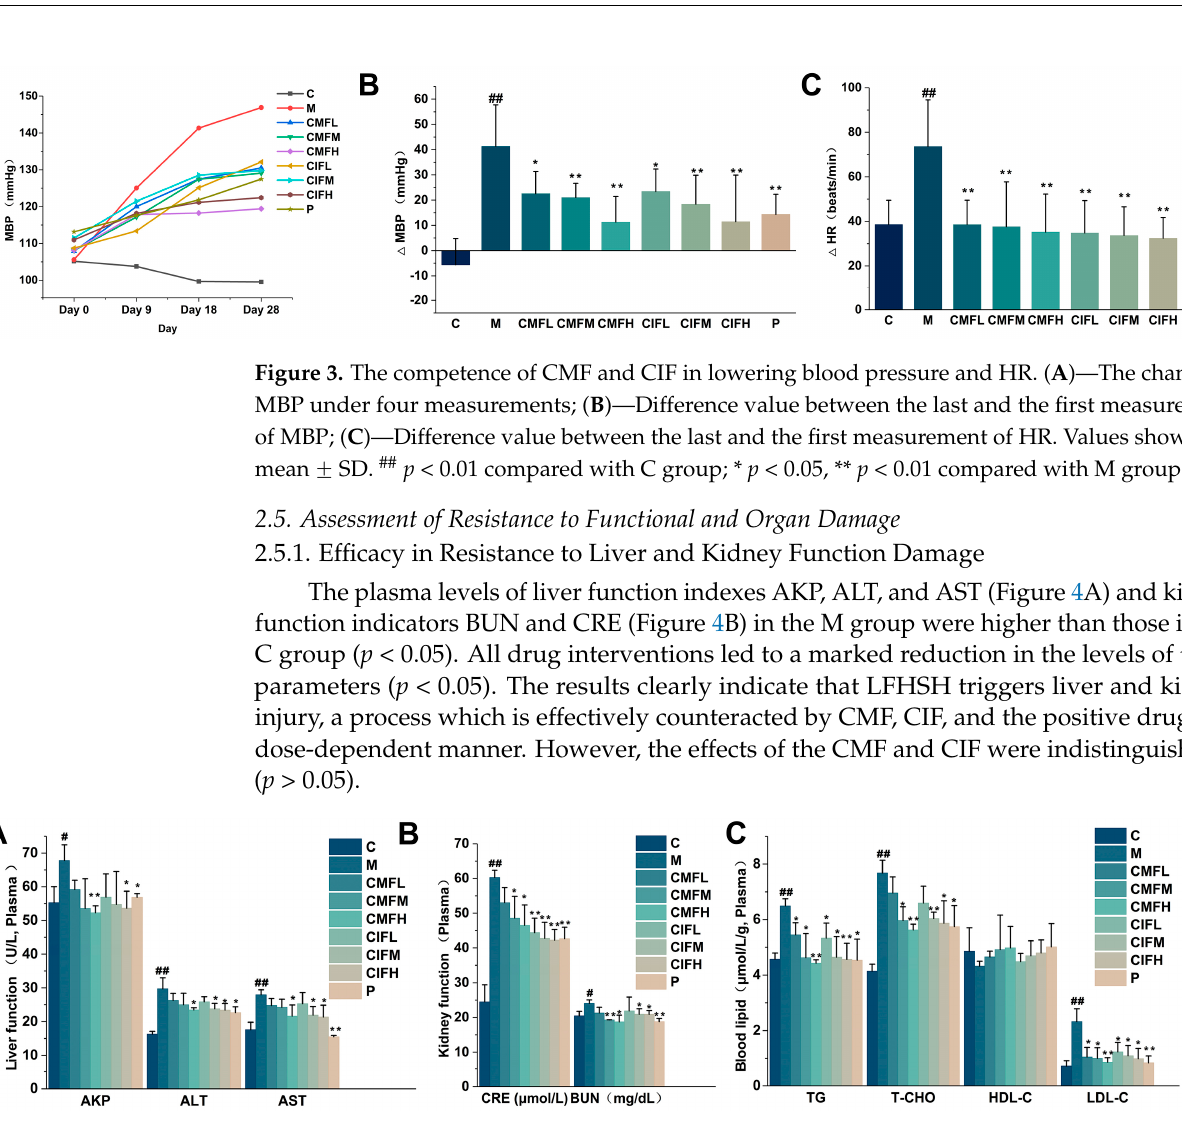
Figure 4. The power of CMF and CIF to resist functional damage. ( A – C )—Determined results of liver, kidney function indicators, and blood lipid indexes. Values shown are mean ± SD. # p < 0.05, ## p < 0.01 compared with C group; * p < 0.05, ** p < 0.01 compared with M group.